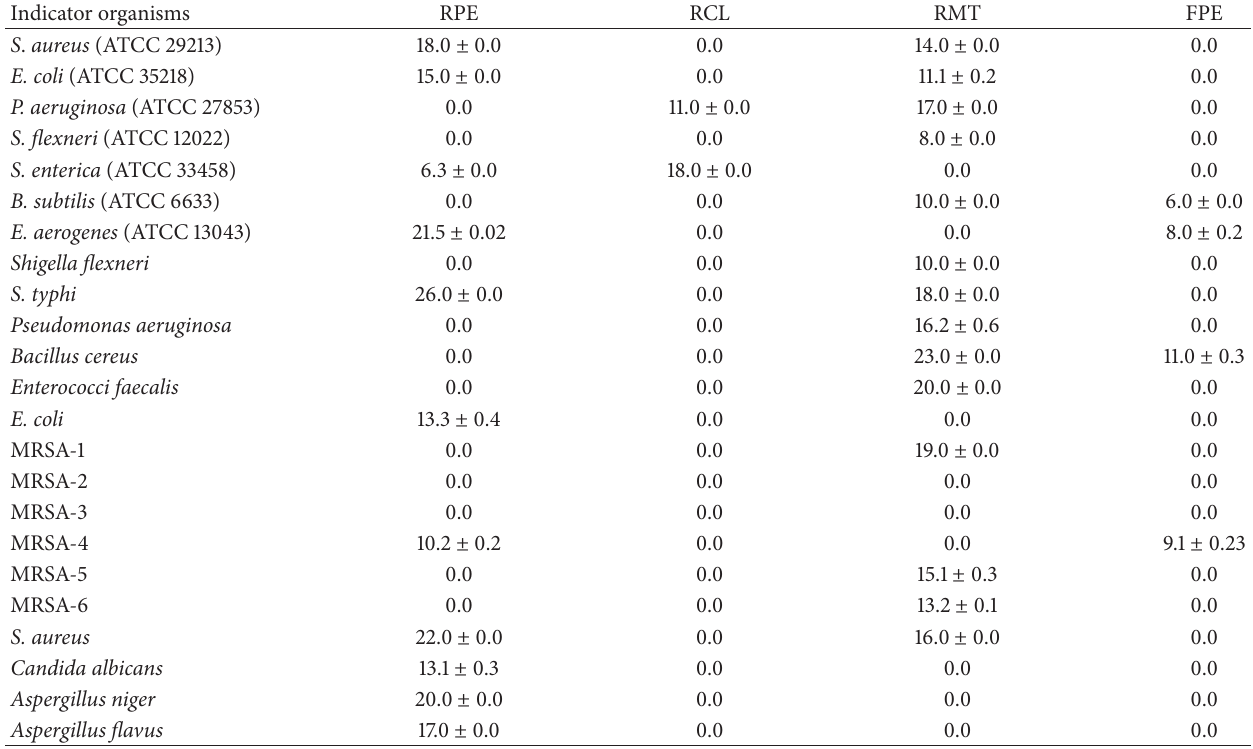
Table 4: Zones of inhibition of purified fractions against tested organisms at 2.0